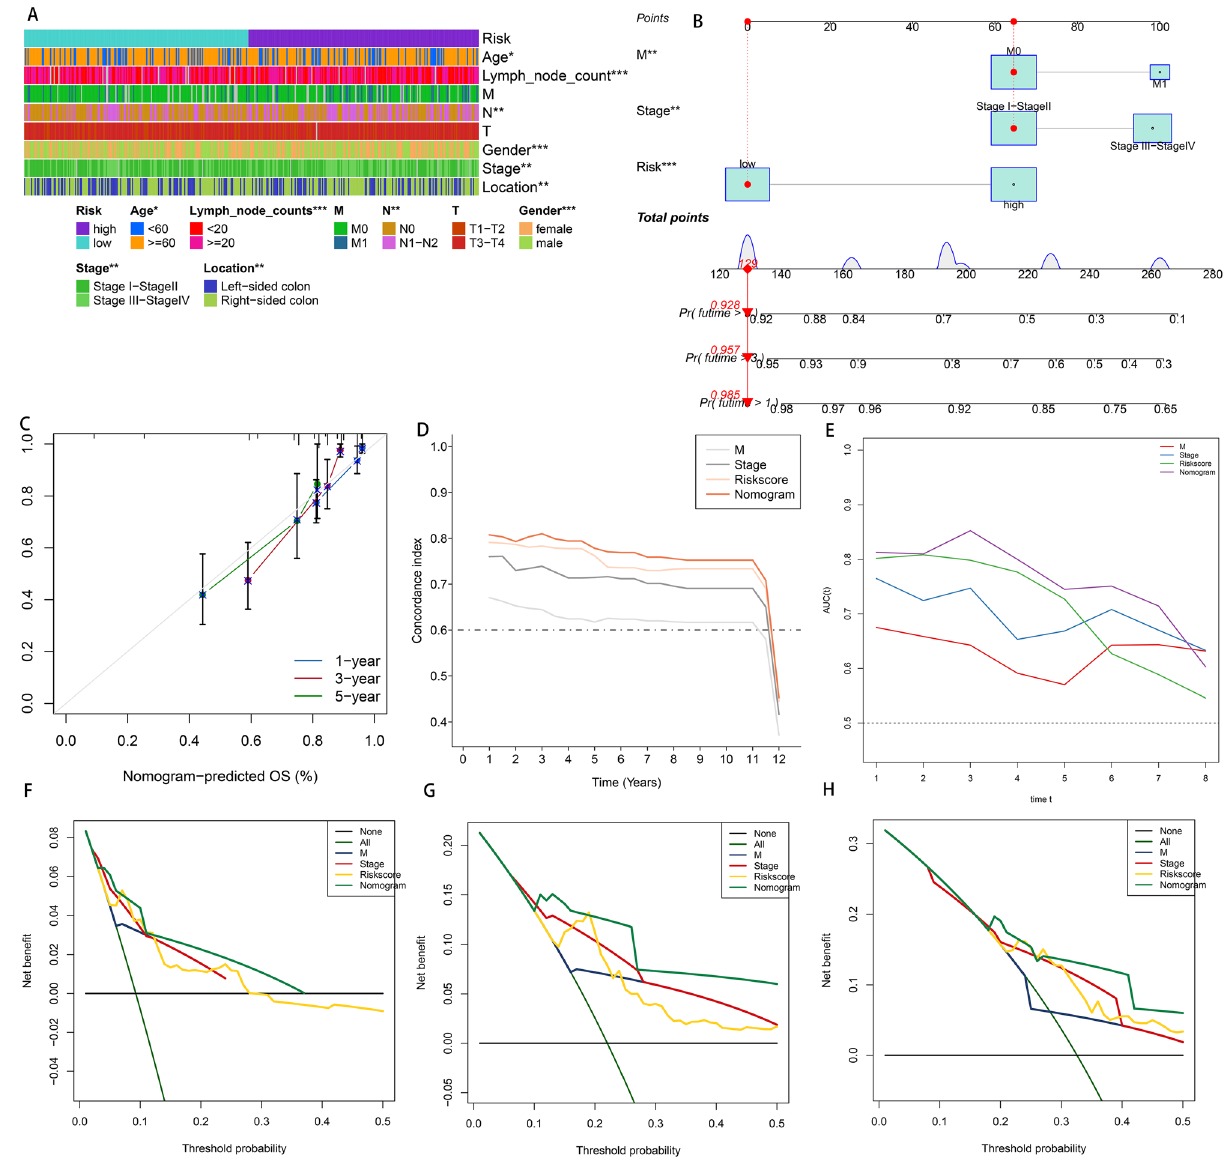
Figure 7. Correlation of signature with clinical factors and identification of the composite prognostic nomogram in the whole set. ( A ) Heatmap presents the distribution of clinical features and corresponding risk score. ( B ) Nomogram prediction of 1-, 3-, 5-year OS. ( C ) Calibration curves of observed and predicted probabilities for the nomogram. ( D ) Concordance index plot for the nomogram. ( E ) Time-dependent ROC curves for the nomogram. ( F – H ) DCA curves for the nomogram in 1-, 3-, 5-year OS. *P < 0.05; **P < 0.01; ***P <